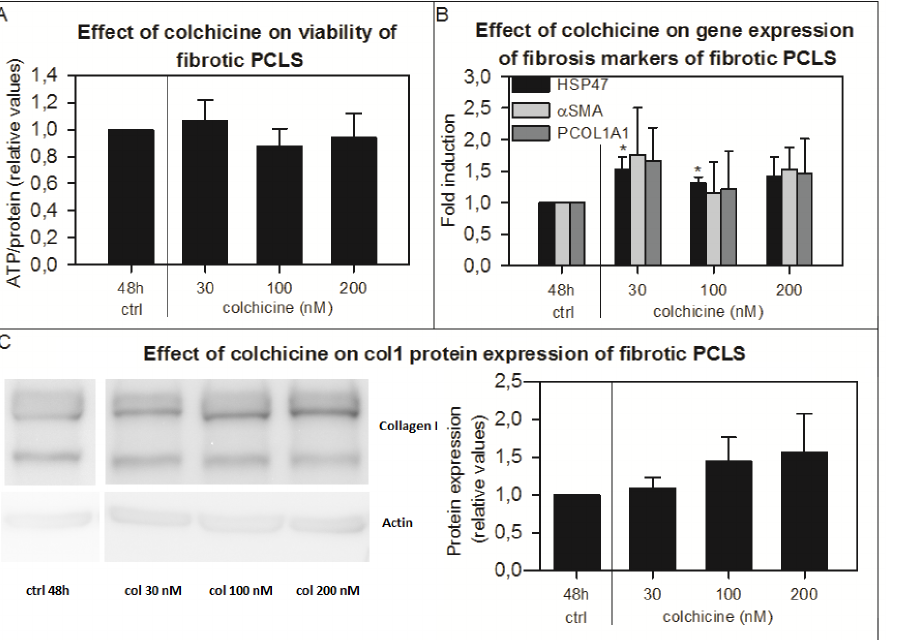
Figure 6. The effect of colchcine in fPCLS on viability, gene expression of fibrosis markers and collagen 1 protein expression. The effect of colchicine (n=4) on the viability (A), on the gene expression of fibrosis markers Hsp47 , a Sma and Pcol1A1 (B) and on the collagen 1 protein expression (pictures are from a representative experiment) (C) of fPCLS from livers from BDL rats incubated for 48 hours. Error bars represent SEM. *p , 0.05 vs 48h.